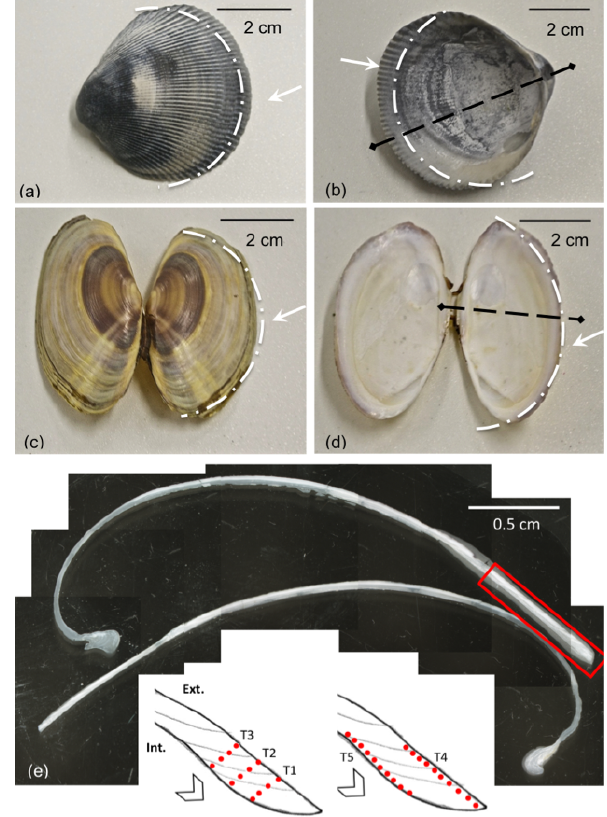
Figure 2. Photographs of the external (left) and internal (right) views of the bivalves Fulvia tenuicostata (a, b) and Soletellina bi- radiata (c, d) . (e) A photo mosaic showing the ventral margin ( S. biradiata ) as seen in a thin section. Powder was sampled from the ventral margin for X-ray diffraction analysis (the white dashed lines and arrows in a, b, c and d ). The area adjacent to the ventral margin was then targeted for confocal Raman microscopy, LA-ICP-MS and EPMA (the red box in e ). The lower panel shows a representation of the laser spots along five transects (T1–T5). T1–T3 are parallel to the shell edge, and T4 and T5 are parallel to the external and internal shell margin